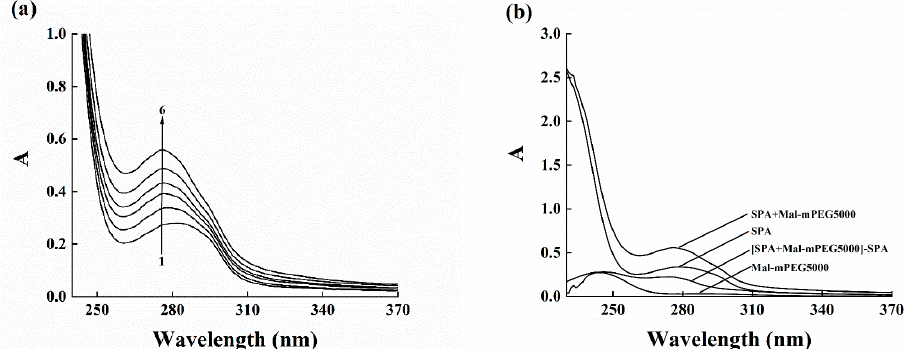
Figure 4. Ultraviolet absorption spectra of Mal-mPEG5000 to SPA. ( a ) UV–visible absorption spectrum of β -amylase upon addition of mPEG at 298 K. c(SPA) = 62.5 μ M; c(Mal-mPEG5000) = 0.0, 62.5, 125.0, 187.5, 250.0 and 312.5 μ M for curves 1–6. ( b ) UV–visible absorption spectrum of subtraction result.